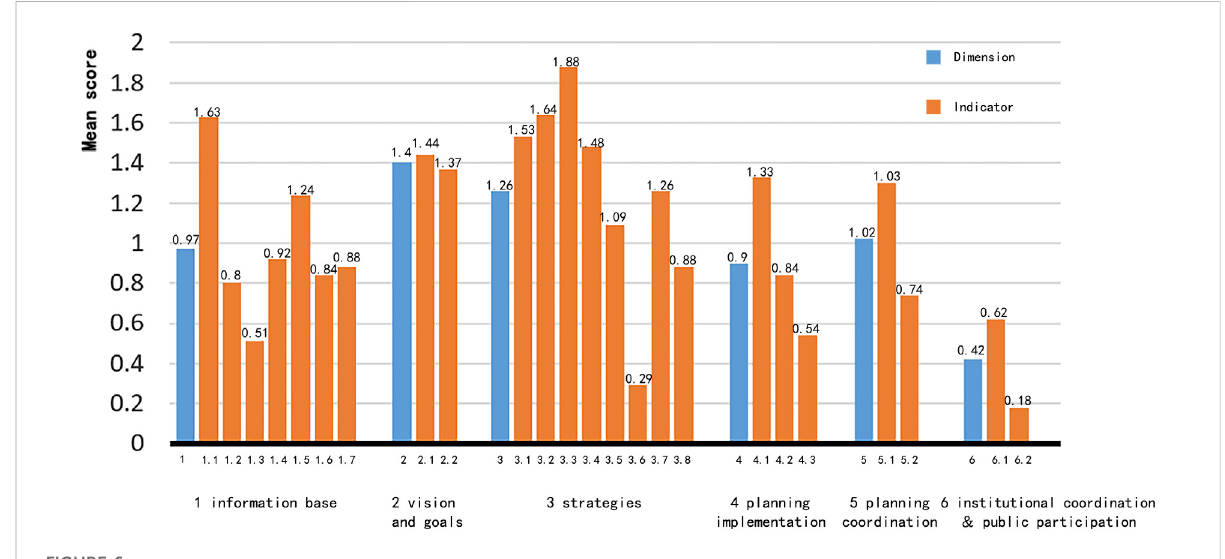
FIGURE 6 Scores of indicator items under the six